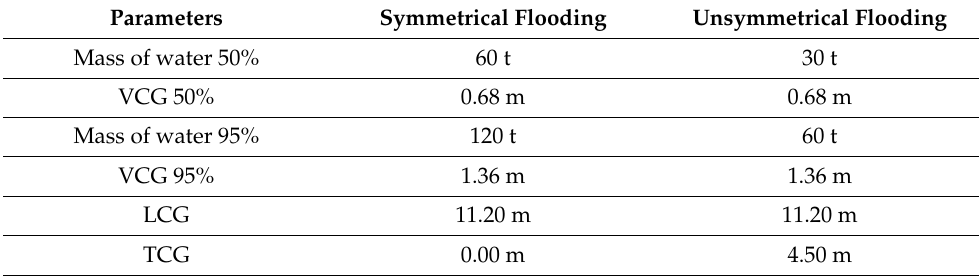
Figure 9. Flooding of watertight compartments. Table 4. Parameters of water draining down into watertight compartments.